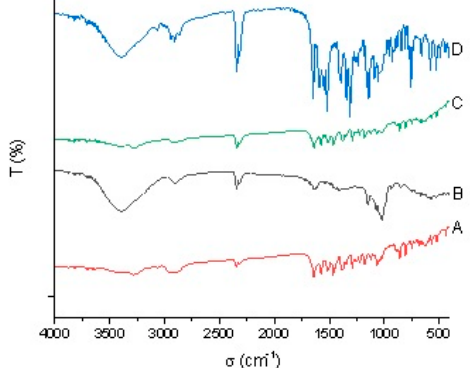
Figure 3. Fourier transform infrared spectroscopy (FTIR) results: ( A ) diuron; ( B ) β -CD; ( C ) the inclusion complex; and ( D ) physical mixture.